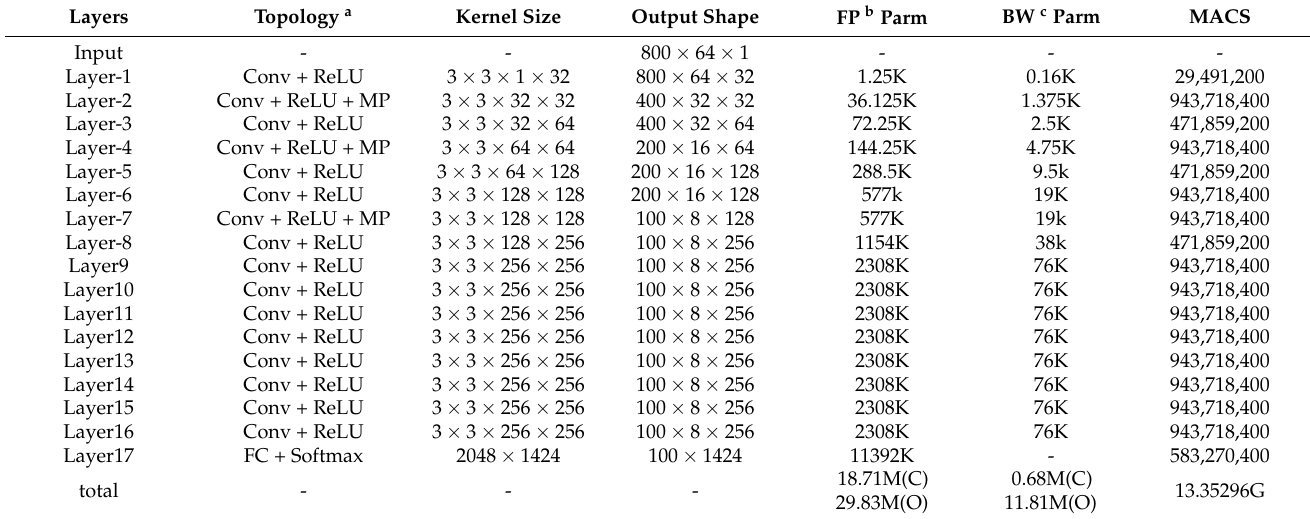
Table 1. Customize VGG-16 Speech Recognition Network Topology